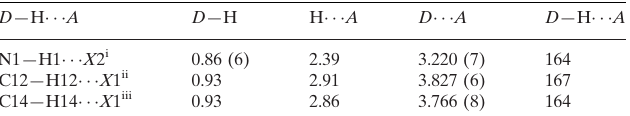
Hydrogen-bond geometry (A˚ , (cid:3) ). X =